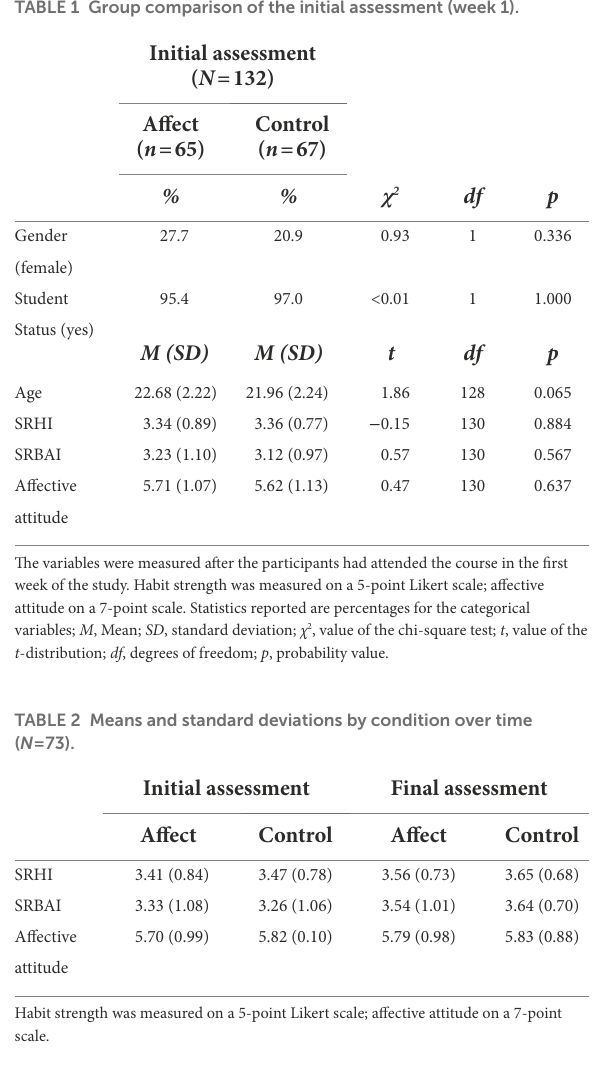
TABLE 1 Group comparison of the initial assessment (week 1).